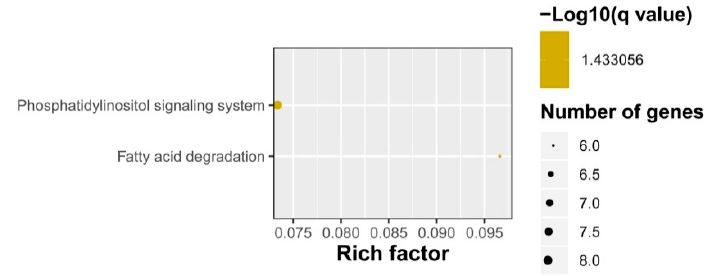
Figure 7. KEGG pathway enrichments of DELs in response to AM fungus.